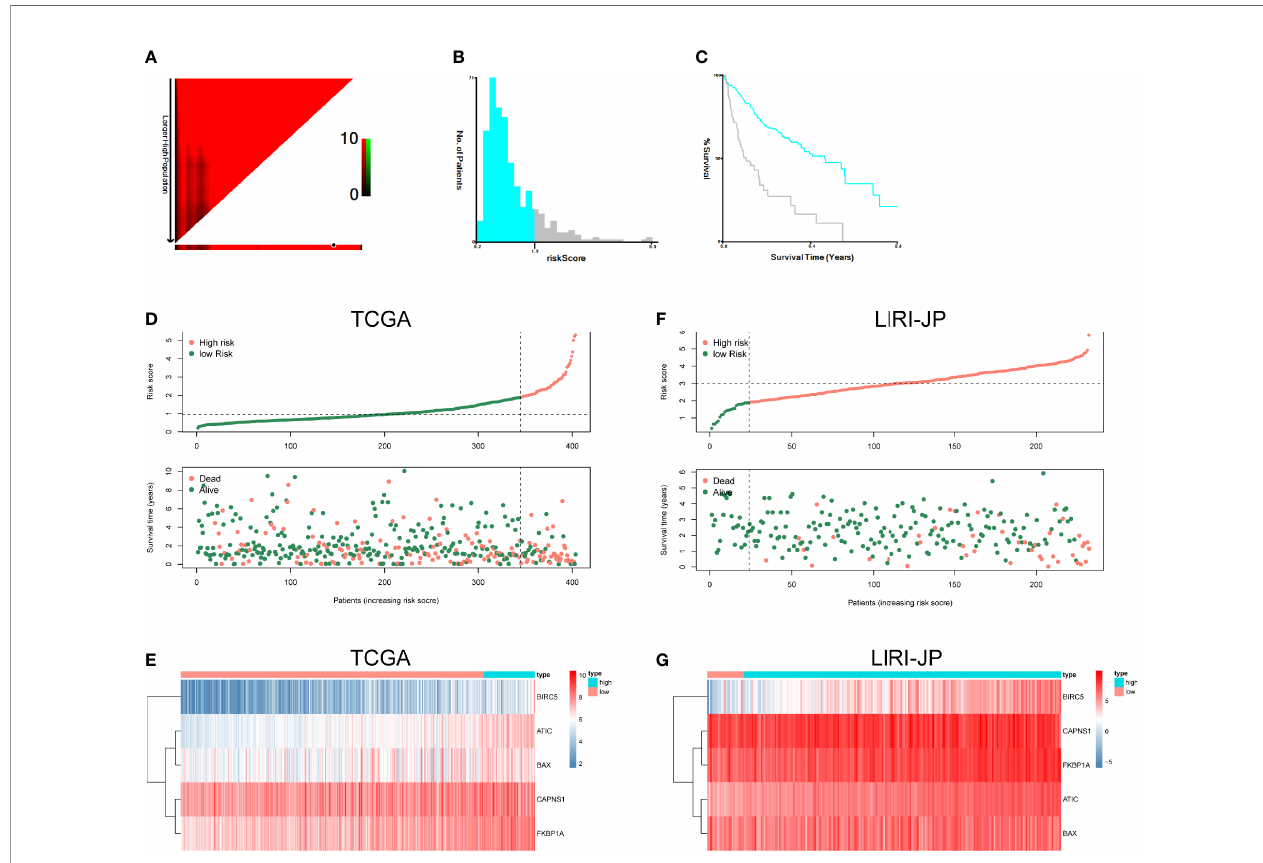
FIGURE 7 | Autophagy-related risk score analysis of patients with HCC. X-tile analysis of the prognostic risk score in TCGA training cohort. (A) The X ‐ tile plots of training group. The black circles highlight the optimal cutoff values. (B) Histogram of the entire cohort divided into low-risk score and high-risk score subgroups according to the cutoff value of 1.9. Blue bars represent the low-risk score group, and gray bars represent the high-risk score group. (C) Kaplan – Meier plot of overall survival (OS) in groups strati fi ed using the optimal cutoff value of the risk score. Blue curves represent the low-risk score group, and gray curves represent the high- risk score group. (D) The risk score distribution and OS of patients in TCGA database. (E) Heatmap of the expression pro fi les of the fi ve genes in TCGA database. (F) The risk score distribution and OS of patients in the ICGC database. (G) Heatmap showing the expression pro fi les of the fi ve genes in the ICGC